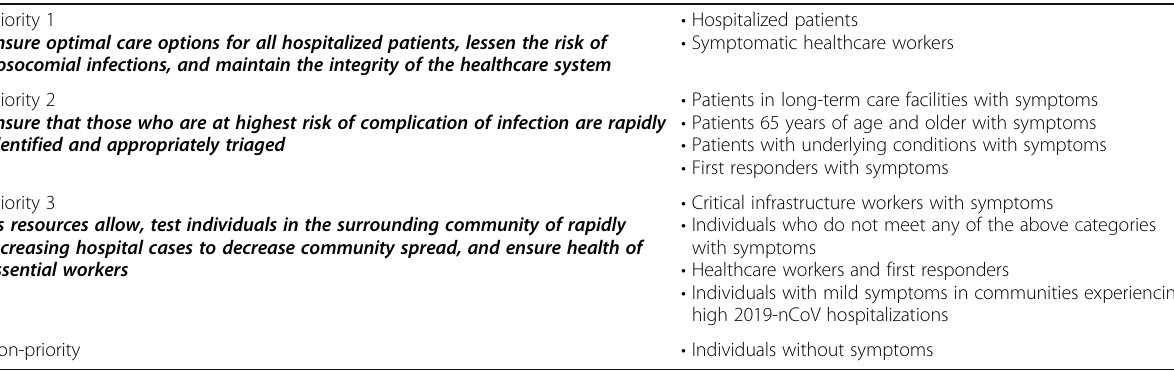
(cid:129) Hospitalized patients (cid:129) Symptomatic healthcare workers